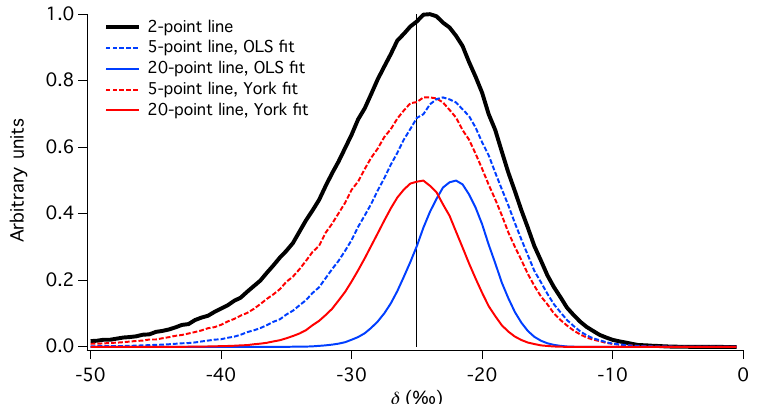
Figure B2. Distributions of the y intercepts retrieved from Keeling plots with a true intercept of − 25‰ (indicated by the vertical line). The black curve was obtained from 10 6 two-point plots. The red curves were obtained using the York equations on 10 6 5-point or 20-point plots. The blue curves were obtained using OLS on 10 6 5-point or 20-point plots. The heights of the curves have been adjusted independently for presentation and convey no